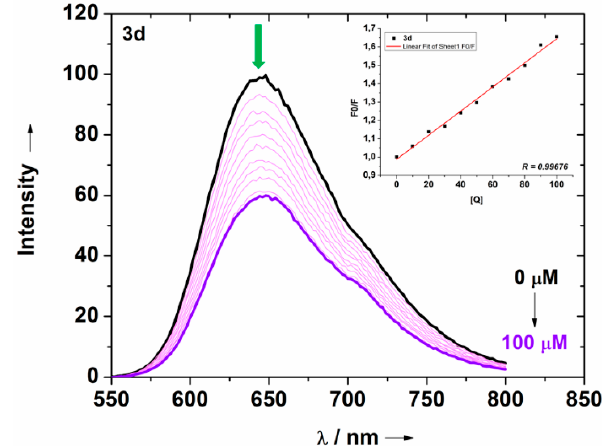
Figure 5. Emission fluorescence spectra of ethidium bromide (EB) bound to ct-DNA in the presence of porphyrin 3d in a DMSO/Tris-HCl buffer mixture at λ exc = 510 nm. The arrow indicates the changes in fluorescence intensities at increasing sample concentrations. The insert graph shows the plot of F 0 /F versus [ct-DNA]. Table 4. DNA-binding data of thioaryl-porphyrin derivatives 3a – d . Absorption Emission Porphyrin